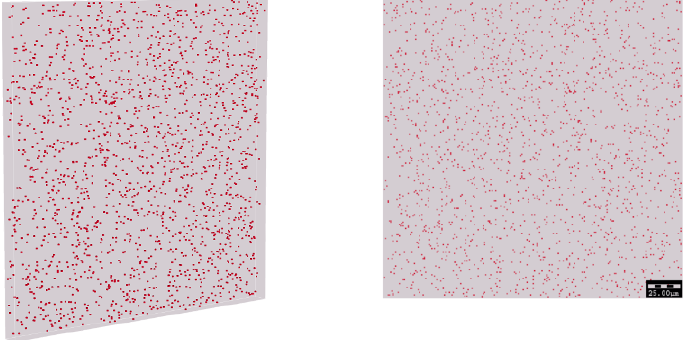
Figure 3. Medium 2: binary composite: discretization in 240 × 240 × 12 voxels; matrix material (grey) and 1 × 1 × 1 inclusions (red) identically distributed; 3D view (left) and 2D projection